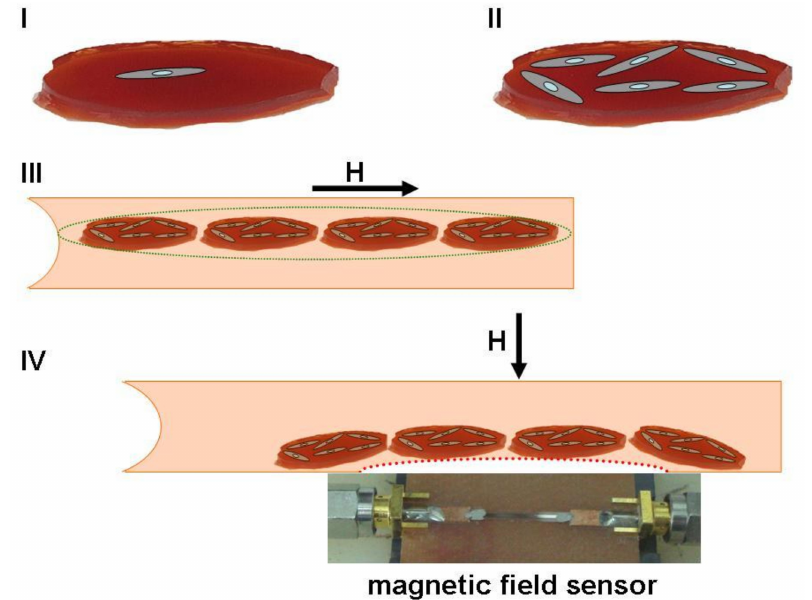
Figure 9. Schematic illustration of PAAm-100 + iron oxide γ -Fe 2 O 3 MNPs-based delivery system. I—initial cell cultivation stage onto the surface of ferrogel scaffold; II—final cell cultivation stage